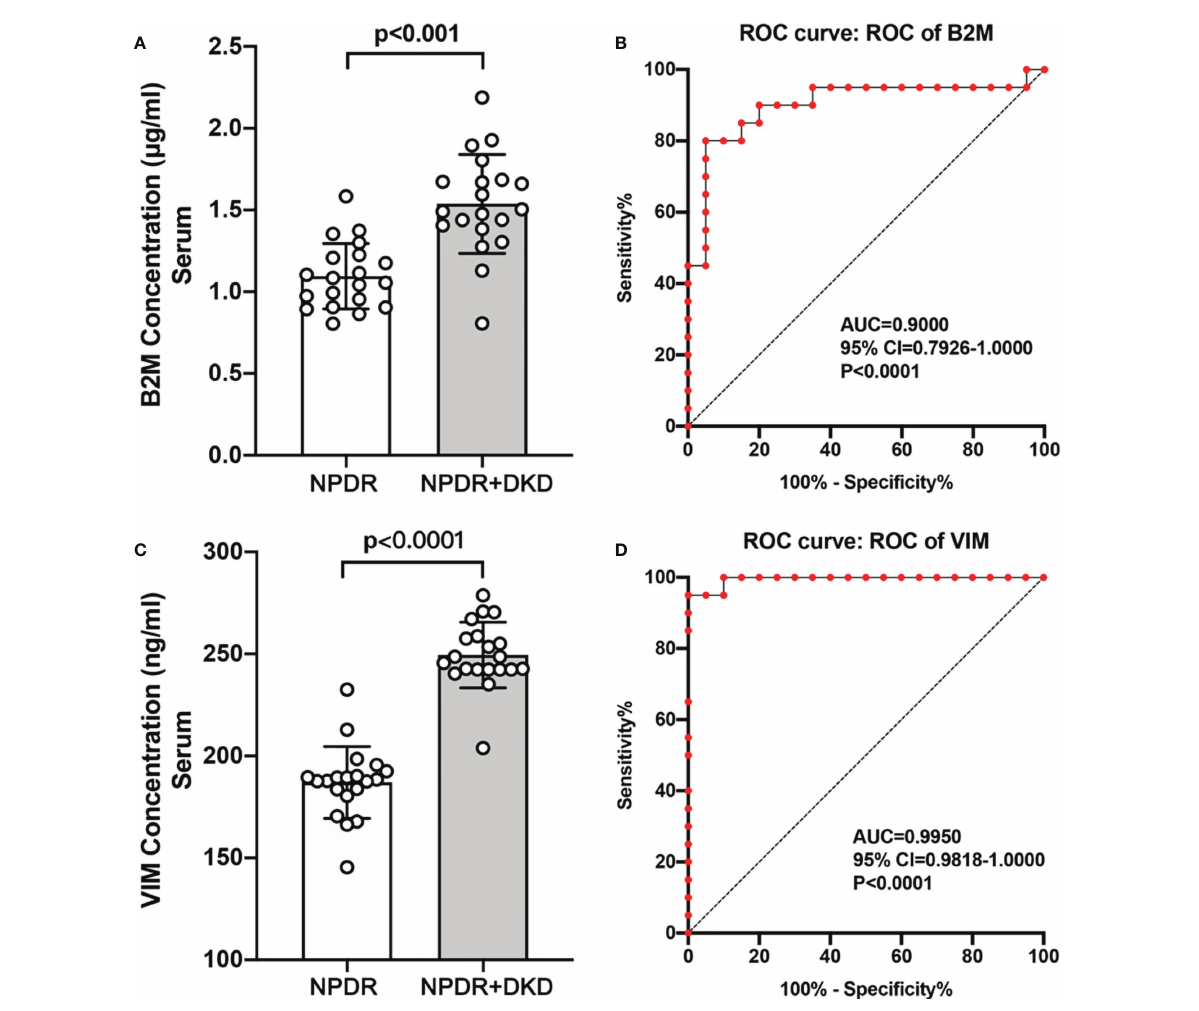
FIGURE 7 Validation of B2M and VIM by ELISA and ROC analysis. (A, C) . The ELISA results showed that the expression of B2M and VIM was signi fi cantly upregulated in the NPDR+DKD group compared with the NPDR group. (B, D) ROC curves depicting the classi fi cation power of B2M and